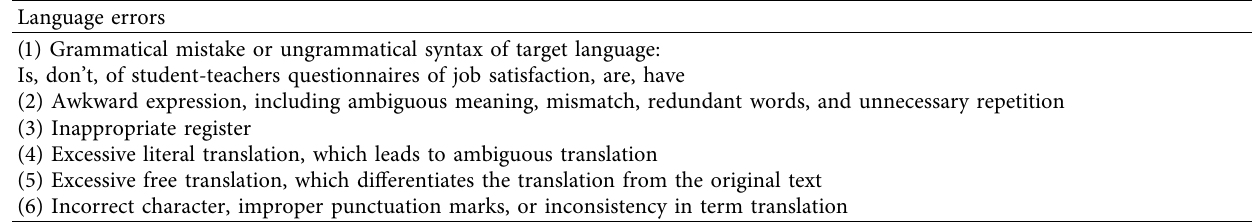
Table 2: Language errors related to Sample 1.